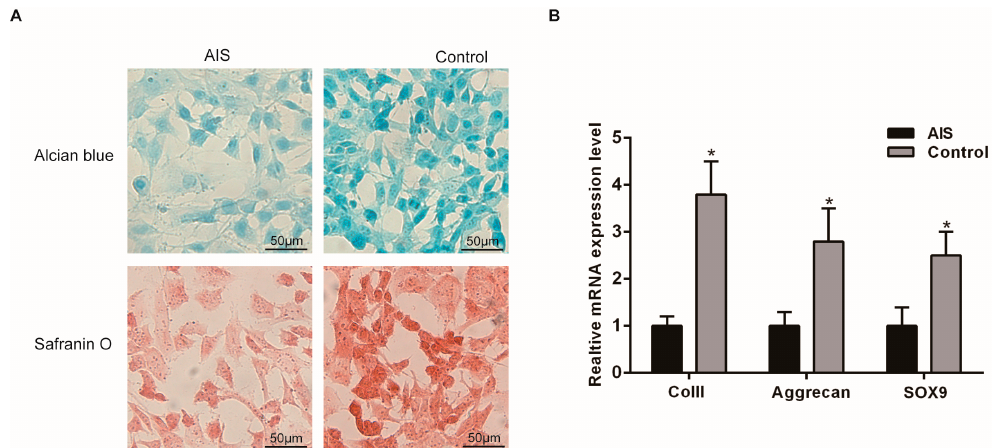
Figure 1. Differences in histochemical staining and the expression of chondrogenic marker genes in primary chondrocytes isolated from the AIS and control groups. ( A ) Glycosaminoglycans (GAGs) and proteoglycan content were visualized by Alcian blue and Safranin O staining, respectively. The control group showed stronger staining than the AIS group. Scale bars = 50 μ m; ( B ) Total RNAs were extracted from the two groups. The relative mRNA expression levels of chondrogenic marker genes, including ColII, Aggrecan and Sox9, were detected by quantitative real-time PCR. The Y axis represents the fold change in transcript levels in the control and the AIS groups. The AIS group was set to 1.0. The data are displayed as the means ± SDs from 3 experiments. * p < 0.05 vs. the AIS group.